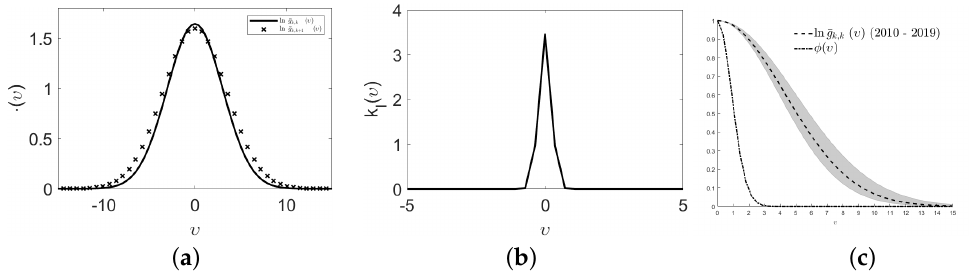
Figure 12. Average natural logarithm PACF and average natural logarithm PCCF (( a ), left plot), k M ( v ) (( b ), centre plot), cross-section on the positive real line of natural logarithm PACF, and corresponding chosen basis function (( c ), right plot).